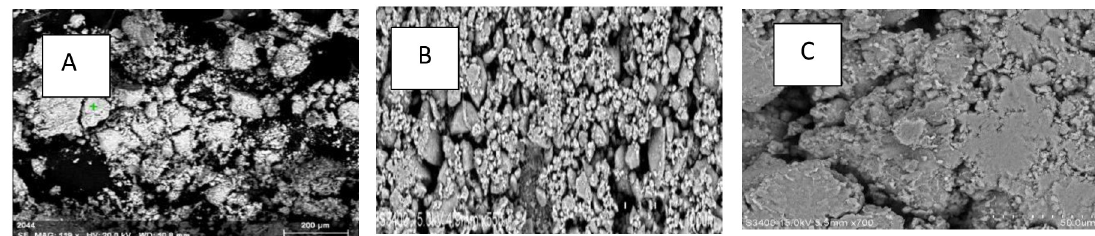
Fig 21. SEM images of HAp powder a) before and b) after immersion in SBF c) growth of apatite layer after immersion in